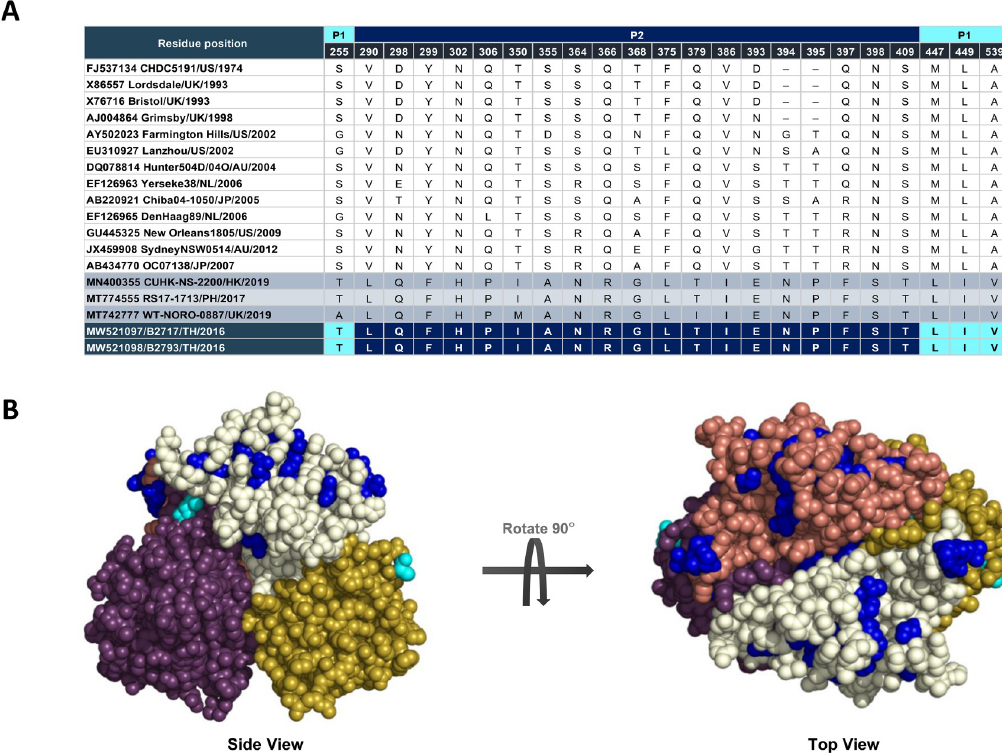
Fig 4. Amino acid residues on the major capsid protein VP1 of GII.4 Hong Kong. A) Amino acid differences in the P1 and P2 domains of the GII.4 Hong Kong compared with other pandemic and non-pandemic GII.4 VP1 sequences. The Thai GII.4 Hong Kong strains B2717 and B2793 are shown in the bottom two rows. B) Characteristic residues common to GII.4 Hong Kong were mapped onto the three-dimensional structure of the dimeric P domain (GII.4 Houston TCH05). Surface-exposed residue changes (light and dark blue) are shown on the P1 and P2 domain, respectively. Each P monomer is colored white/gold and pink/purple.